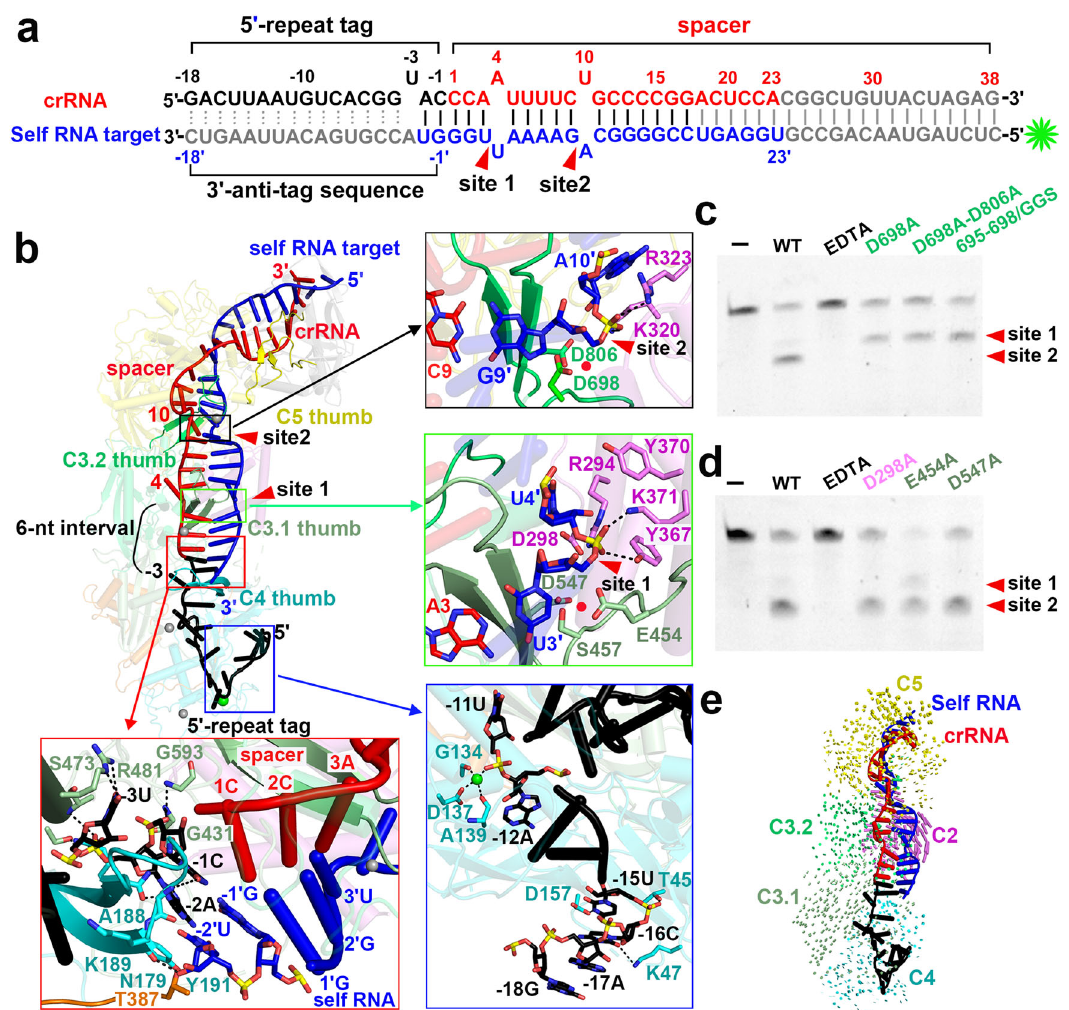
Fig. 2 | Assembly of crRNA-Target RNA Duplex in gRAMP crRNA -Target RNA self complex. a Schematic drawing for the sequences of crRNA and self RNA target. PotentialcleavagesitesaremappedonthetargetRNAsequence.Segmentsthatcan be traced are in color, while disordered segments are in gray. The green asterisk indicates the fl uorescencelabel at5 ′ end of the RNA target for the following target RNA cleavage. b The thumb elements of Csm4 and Csm3 domains kink the crRNA- targetRNAduplexevery6thnucleotide,withnokinkassociatedwiththethumbof Csm5 domain. The black and green insets present interactions that might con- tribute to RNase activity for the target RNA cleavage at the 9 ′ − 10 ′ step and 3 ′ − 4 ′ step,respectively.TheblueinsetprovidesdetailedcontactsbetweenCsm4domain